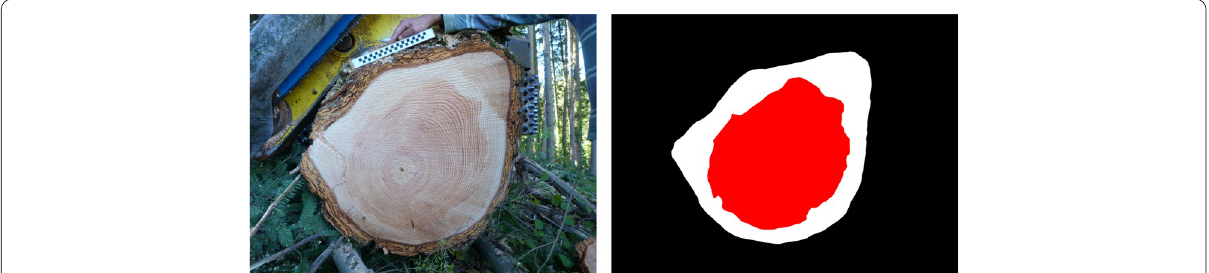
Fig. 16 Raw RGB image of log #1 from tree #1 taken in the forest (on the left) and the corresponding manually segmented image (on the right). On the segmented image: The white area is the sapwood located between heartwood and bark; the red area is the